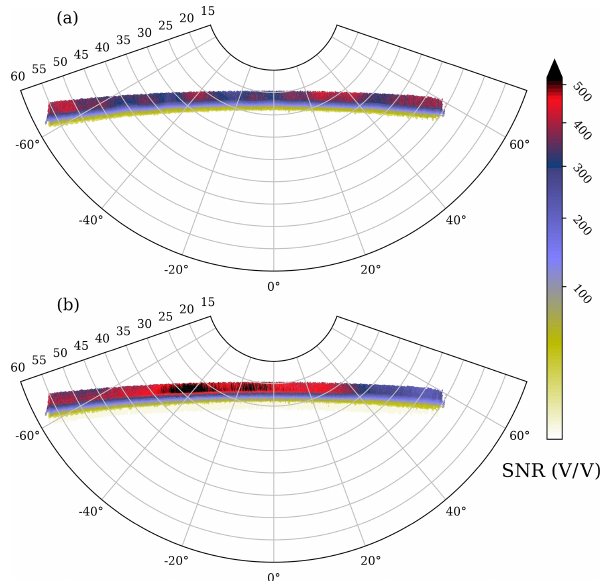
Figure 5. Effective antenna pattern for the signal-to-noise ratio (color scale) at (a) the horizontal port and (b) the vertical port, as a function of azimuth ( x axis) and elevation ( y axis) in the antenna reference frame ( ϕ A , θ A